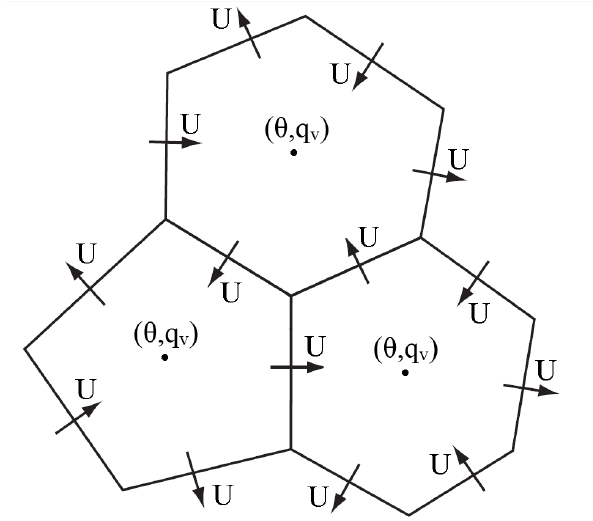
Figure 1. A schematic of C-grid staggered variables on the MPAS- A horizontal mesh. Normal wind velocities ( U ) are defined on the cell faces while all other scalar variables are defined at the cell cen- ters, including potential temperature ( θ) and water vapor mixing ratio ( q v )